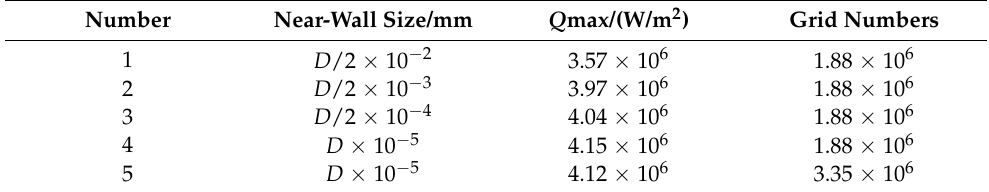
Table 2. The results of grid